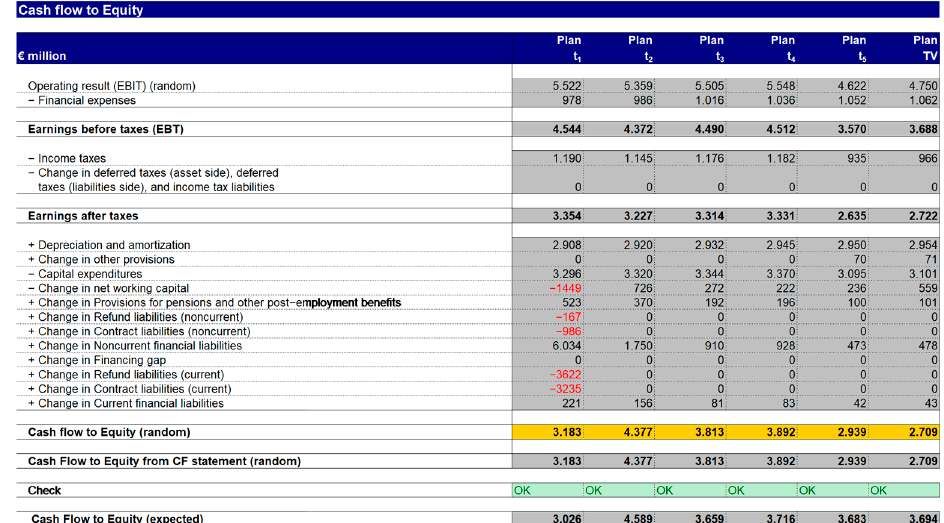
would be overlooked in the absence of simulation-based planning.